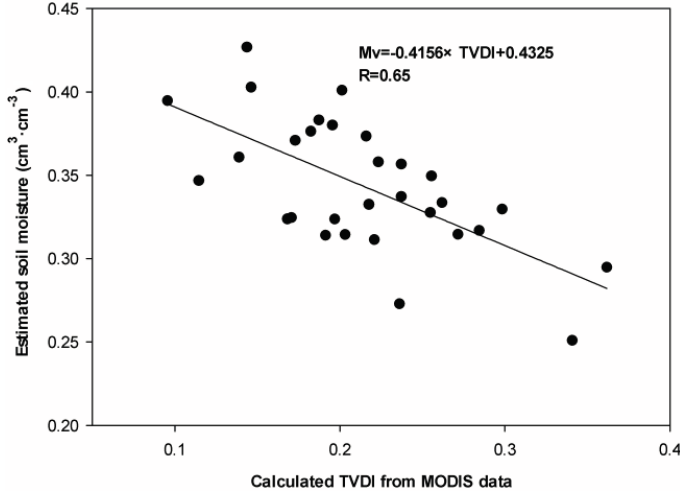
Figure 7. Comparison between estimated soil moisture and MODIS-derived